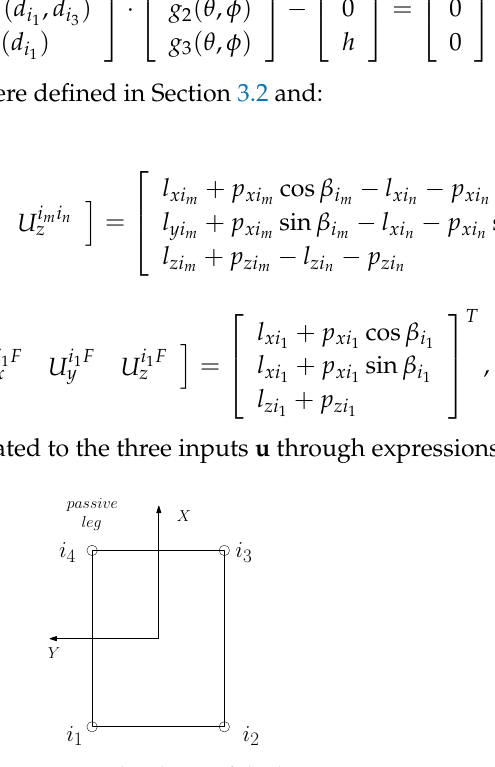
Figure 17. Subindexes of the